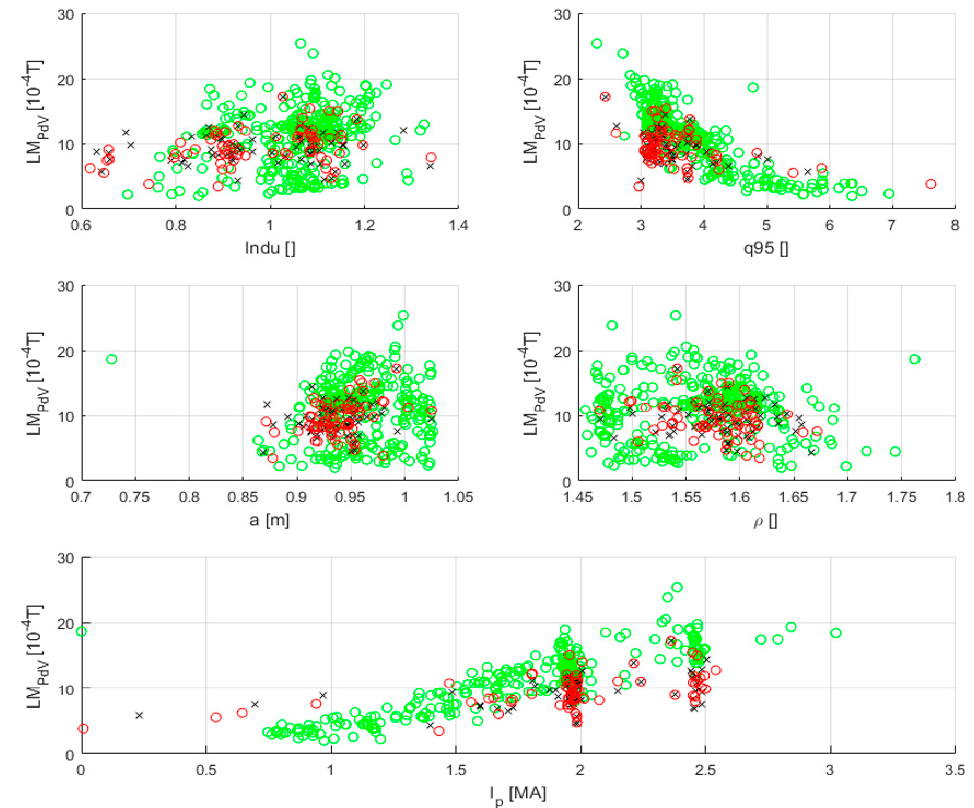
Figure 7. Plots of the critical value of the locked mode, predicted by Equation (3), versus the various quantities used in the regression for the examples of campaigns C29–C30. Red circles: critical values of the locked mode at the moment of the alarm. Black crosses: critical values of the locked mode 15 ms before the beginning of the current quench. Green circles: critical values of the locked mode at the flat top of the same discharges. Before the beginning of the current quench, the overlap between the values of the locked mode is almost complete. Table 3. The traditional figures of merit to assess the performance of predictors for the case of Equation (3) applied to campaigns C29–C30.